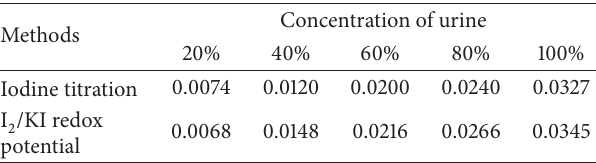
Table 2: Comparison between two methods for the quantities of iodine consumed by urine